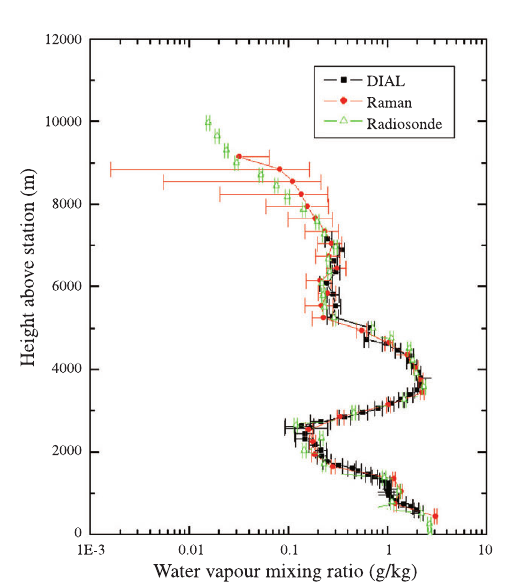
Fig. 9. Vertical profi les of n ( z ) for February 18, H2O 1997: DIAL measurement (22:20-00:20 GMT, black squares), Raman measurement (22:20-00:20 GMT, red circles) and radiosonde profi le (launch at 22:55, green